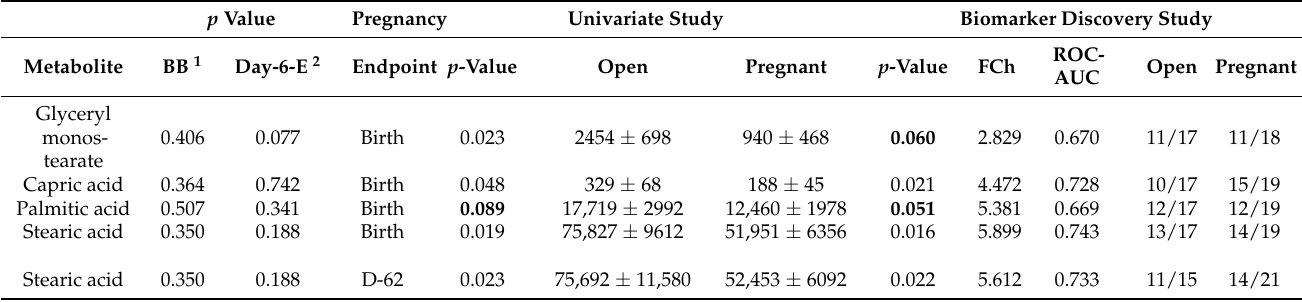
Tendencies 0.05 < p < 0.09 are in bold. p values from major effects are shown: bull breed (BB 1 ) and embryonic stage on Day-6 (Day-6-E 2 ). FCh: Log fold-change in concentrations (open/pregnant). p values: Kruskal-Wallis test (Glyceryl monostearate) or General Linear Model (GLM) procedure (Capric, Palmitic, and Stearic acids), Bonferroni correction ( p < 0.05) (Univariate study) and T -test (Biomarker discovery study). In contrast, glyceryl monostearate (one sample deleted as out layer 1200 × mean value), capric acid, and stearic acid concentrations were significantly lower in embryos that reached birth ( p < 0.05), and palmitic acid tended to decrease (Table 1). None of those metabolites was affected by bull breed, but glyceryl monostearate concentrations tended to differ at Day-6 between morula and blastocyst stages ( p = 0.077). ROC-AUC: Receiver Operator Characteristic—area under